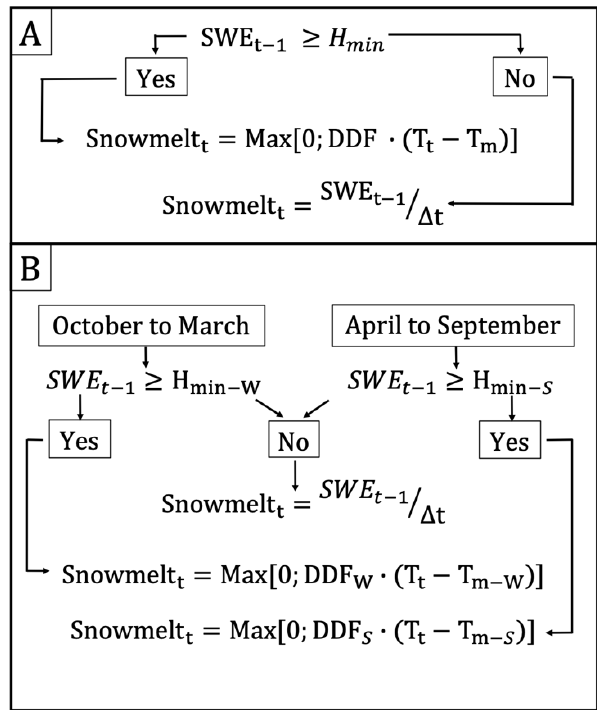
Figure 5. Operating diagram of the snowmelt model for the “all-year” version ( A ) and for the “two-season” version ( B ). The indexes “W” and “S” are used, respectively, to identify the parameters for the winter and the summer period for the two-season version.